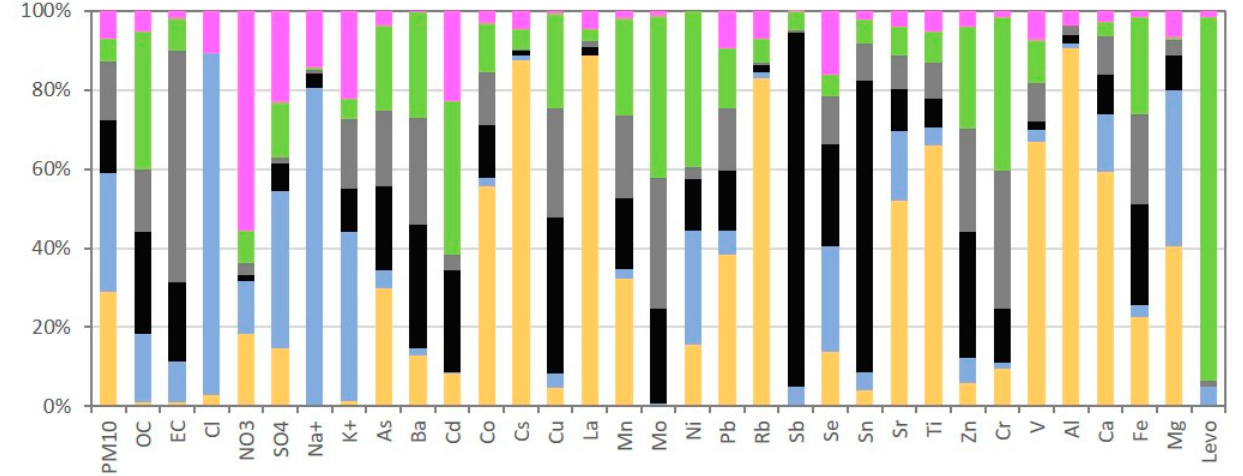
Figure 13. Relative contribution of six PMF factors to PM 10 and individual chemical species measured at a roadside site of Fort-de-France (Martinique Island) in 2018.